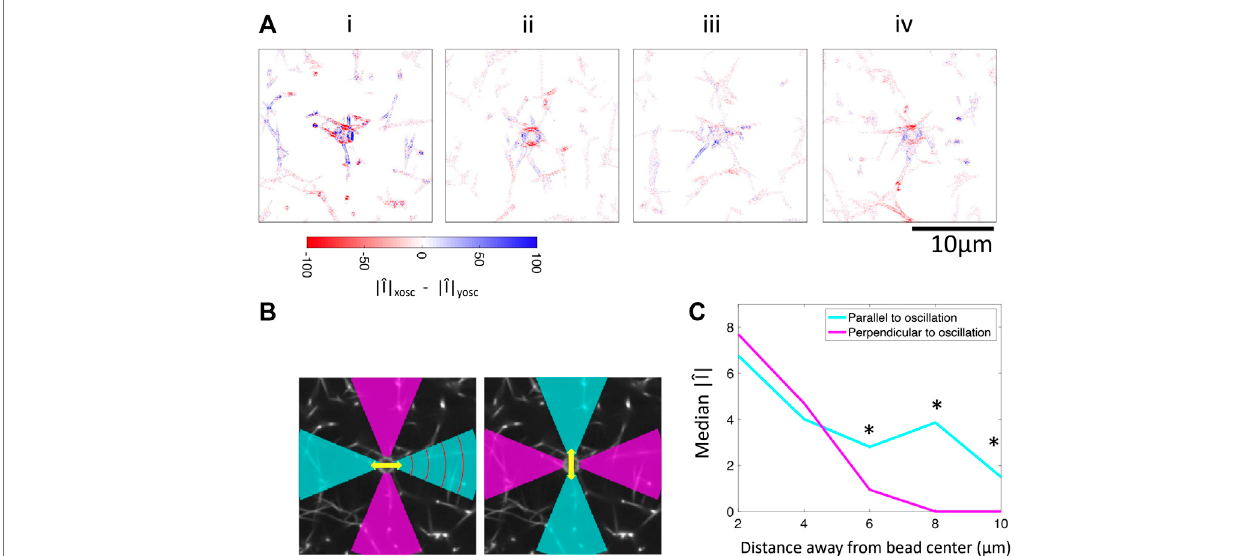
FIGURE6| ComparisonofFouriermagnitudesinresponsetoappliedoscillationsinthe x -directionand y -direction. (A) DifferencebetweenFouriermagnitudeat F d in response to x-oscillation and y-oscillation. Blue indicates greater response to x-oscillation while red indicates greater response to y-oscillation. i – iv match the beads shown in Figure 5 . (B) Image illustrating binning for panel (C) . Yellow arrow indicates the axis of oscillation. π / 4 radian wide regions parallel (cyan) or perpendicular (magenta) to the axis of oscillation are binned according to their distance from the center of the bead with a bin width of 2 μ m, indicated by the red arcs. (C) The median of the Fourier magnitude for each bin is plotted ( Supplementary Figure S2 presents the distribution of the data as violin plots with quartile ranges). *indicates medians are statistically different as determined by Wilcoxon rank sum test ( p < 10 − 5 ).